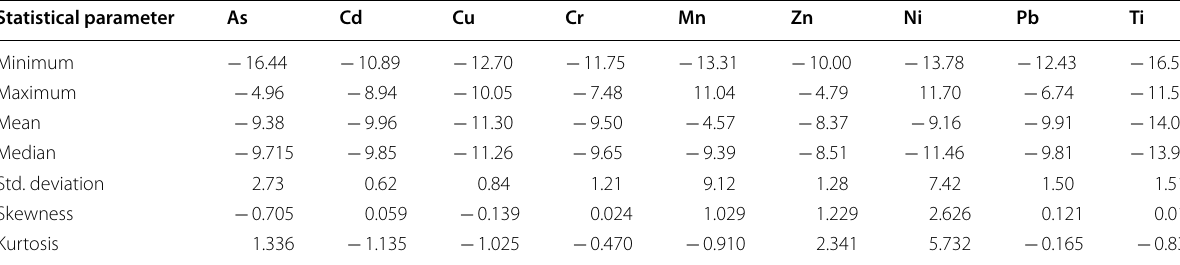
Table 11 Statistical parameters of the geo-accumulation index Statistical parameter